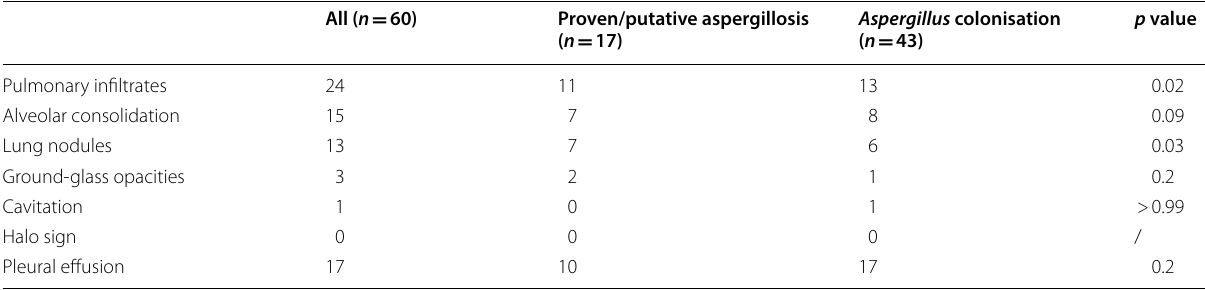
Table 4 Chest CT scan in patients categorised as having proven and putative aspergillosis or Aspergillus colonisation